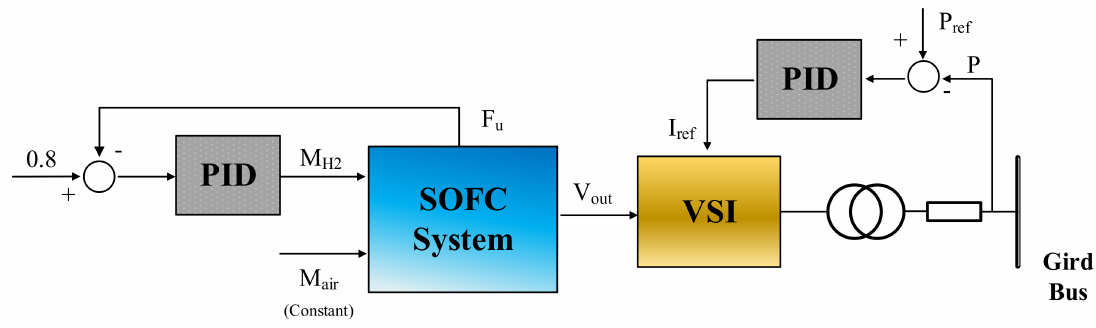
Figure 7. Compared control structure with only two proportional-integral-derivative ( PID)